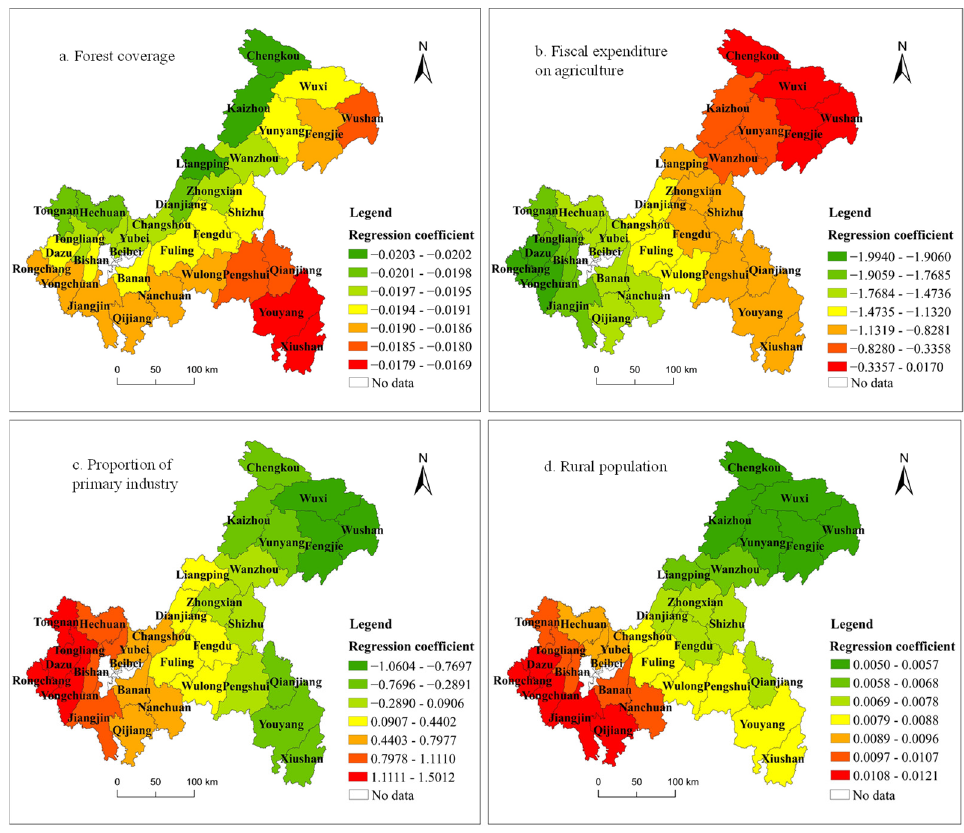
Figure 7. Spatial heterogeneity of influencing factors of the RNCUE values in Chongqing. ( a ) Forest coverage; ( b ) Fiscal expenditure on agriculture; ( c ) Proportion of primary industry; ( d ) Rural population.